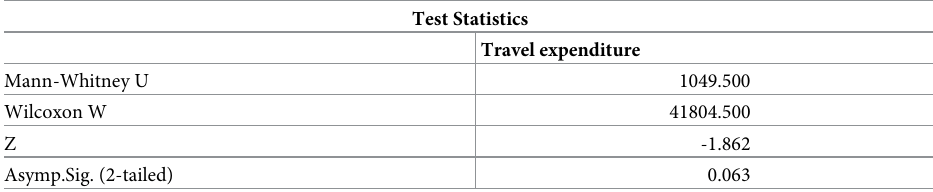
Table 11. Mann-Whitney U test statistics—Travel expenditure by